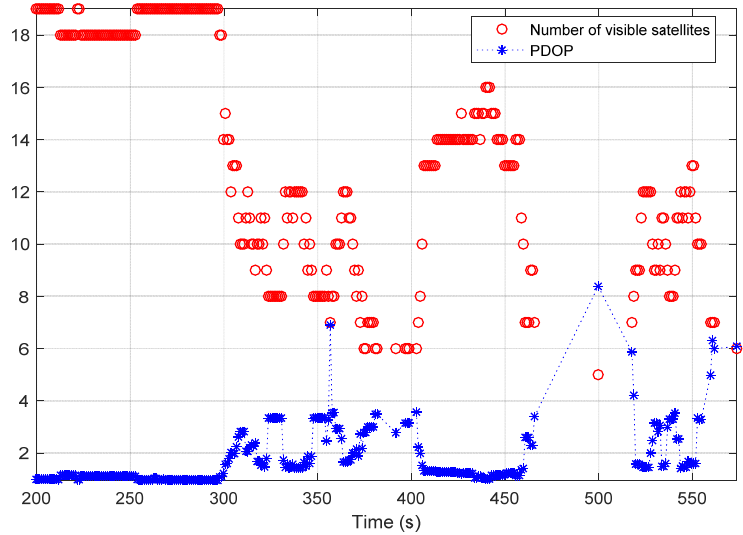
Figure 8. Number of visible satellites and PDOP values in the second test.